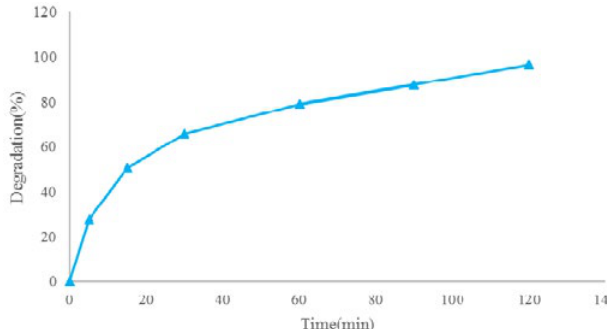
Fig. 6. Effects of Clindamycin concentration on photocatalytic degradation Fig. 6 Effects of Clindamycin concentration on photocatalytic degradation